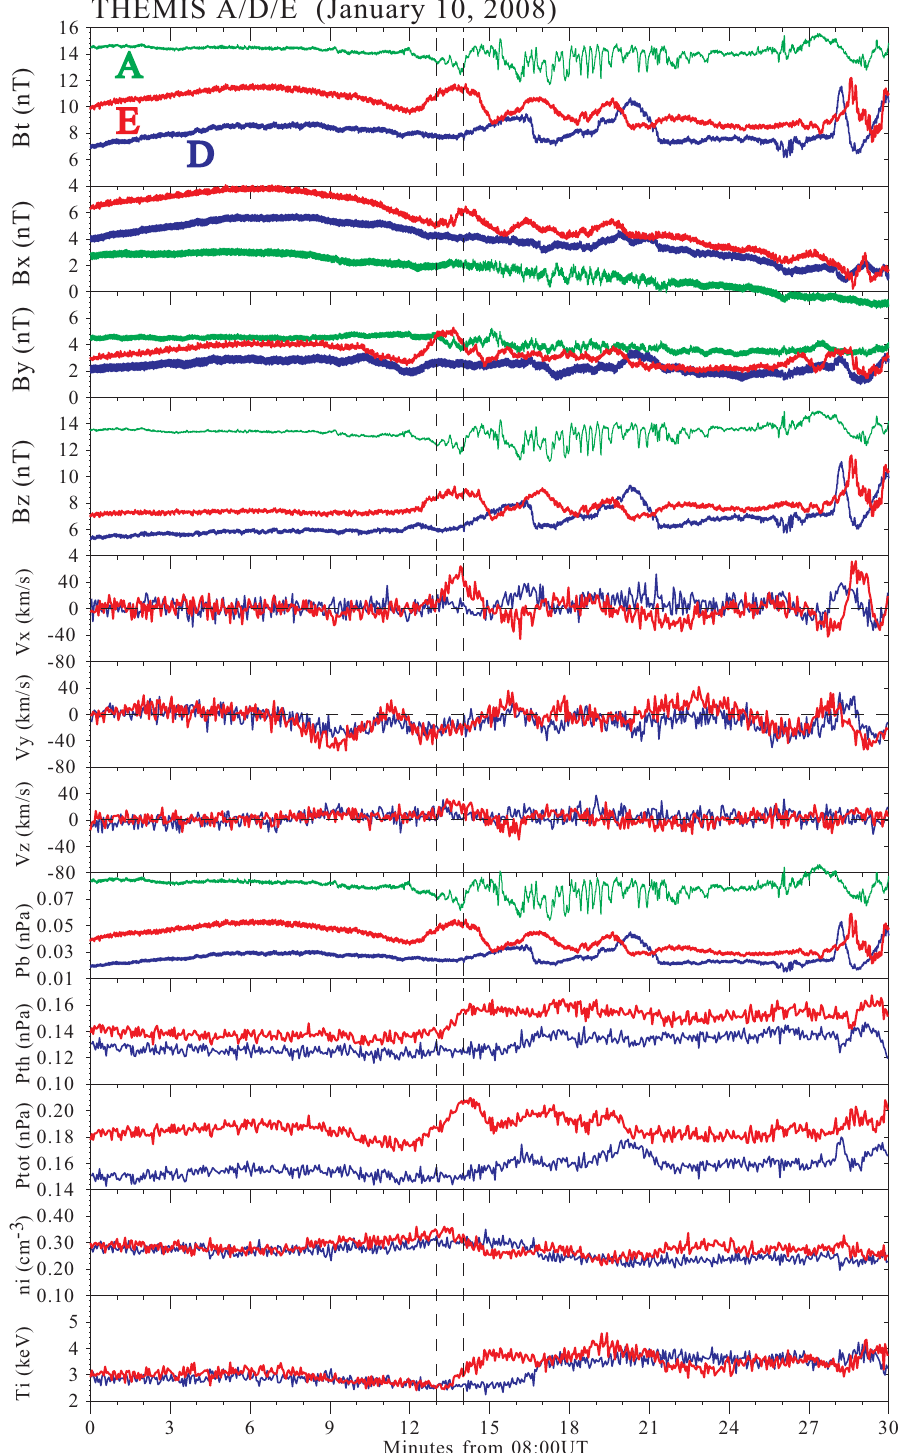
Fig. 4. Magnetic field, bulk flow velocity, magnetic, thermal, and total pressures, and ion density and temperature as obtained by the THEMIS A (green), D (blue), and E (red) satellites at 08:00–08:30UT on 10 January 2008. The magnetic field and the flow velocities are in GSM coordinates. Only the magnetic field data were available for THEMIS